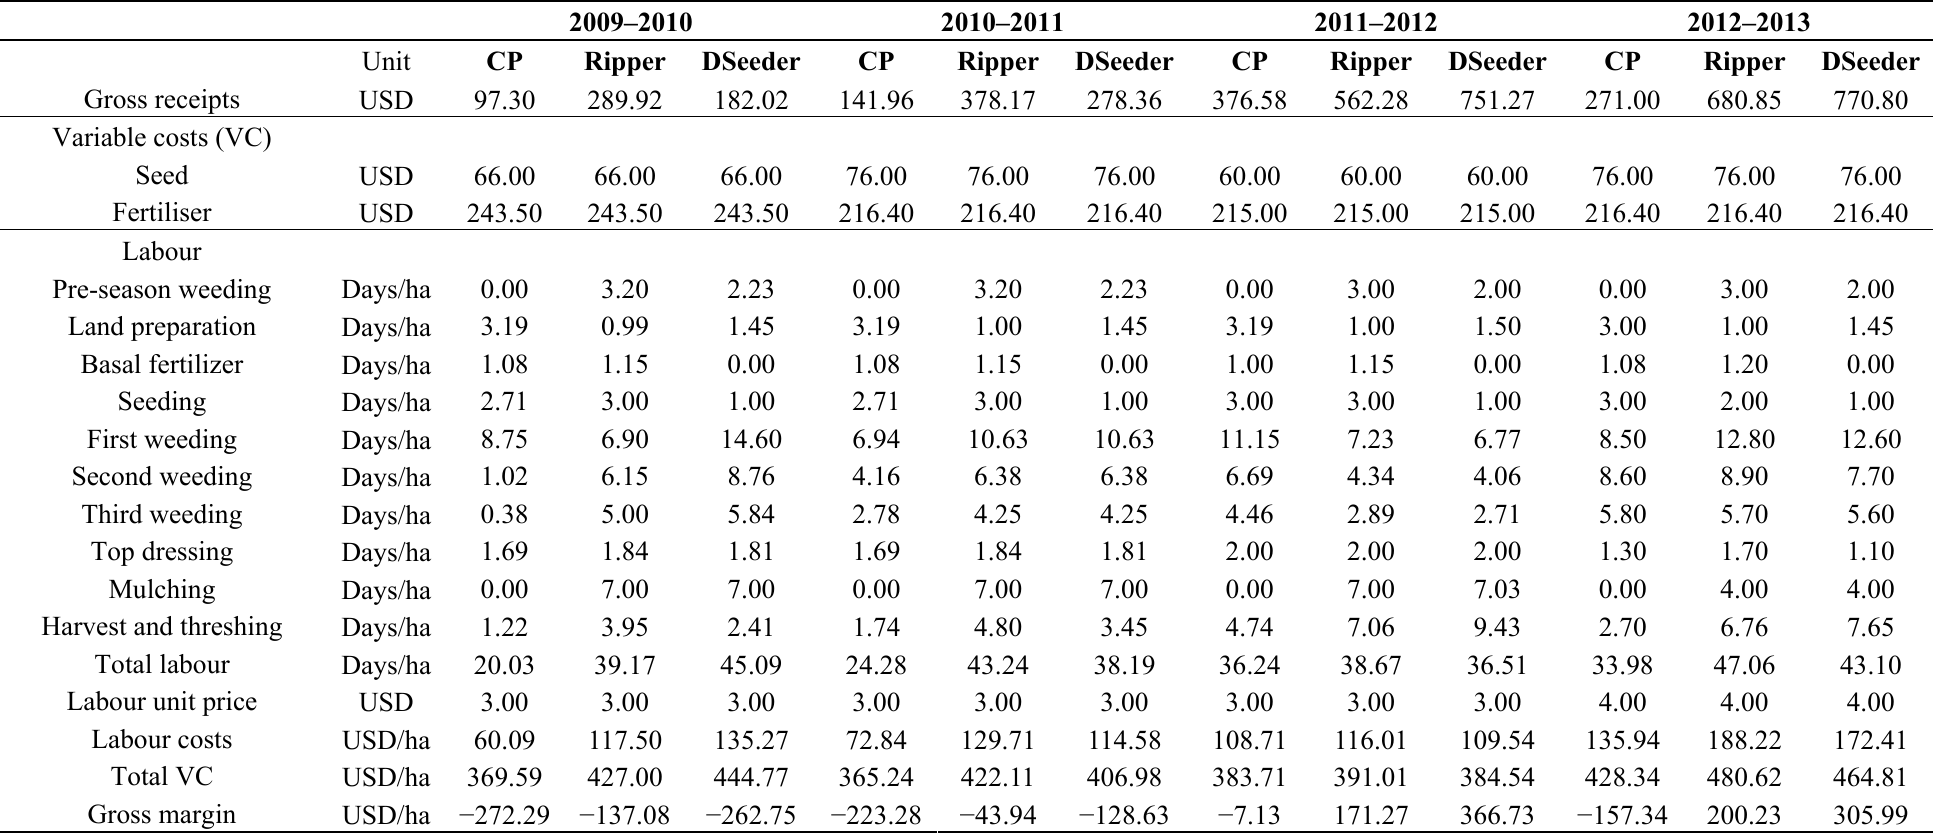
Table 6. Gross margin analysis (in US$·ha −1 ) of different cropping systems practised under on-farm trials at Zimuto Communal Area,